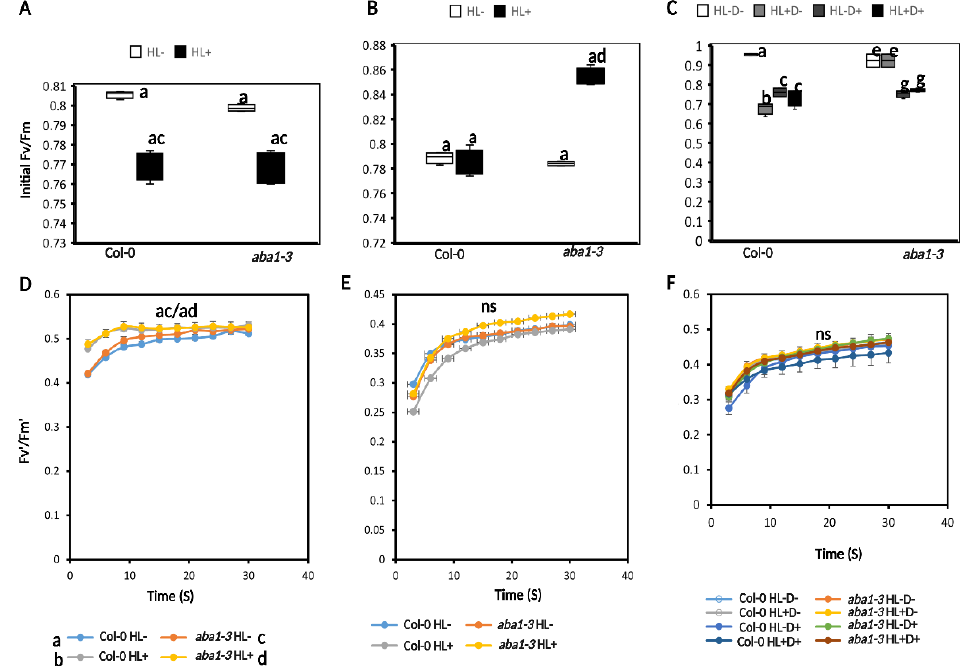
Figure 6. Photosynthetic initiation was not affected by D and HL stress. ( A ) Fv/Fm measurement after HL stress. ( B ) Fv/Fm after 5 days of recovery. ( C ) Fv/Fm after D stress. ( D ) Photosynthesis induction (Fv′/Fm′) over 30 s after HL stress. ( E ) Photosynthesis induction after recovery. ( F ) Photo- synthesis induction after D stress. Data are a representation of one biological replicate with mean values. The second biological replicates are shown in Supplementary Figure S9. Statistical signifi- cance analyzed by one-way ANOVA test and post-hoc Tukey’s HSD test. ns = not significant.